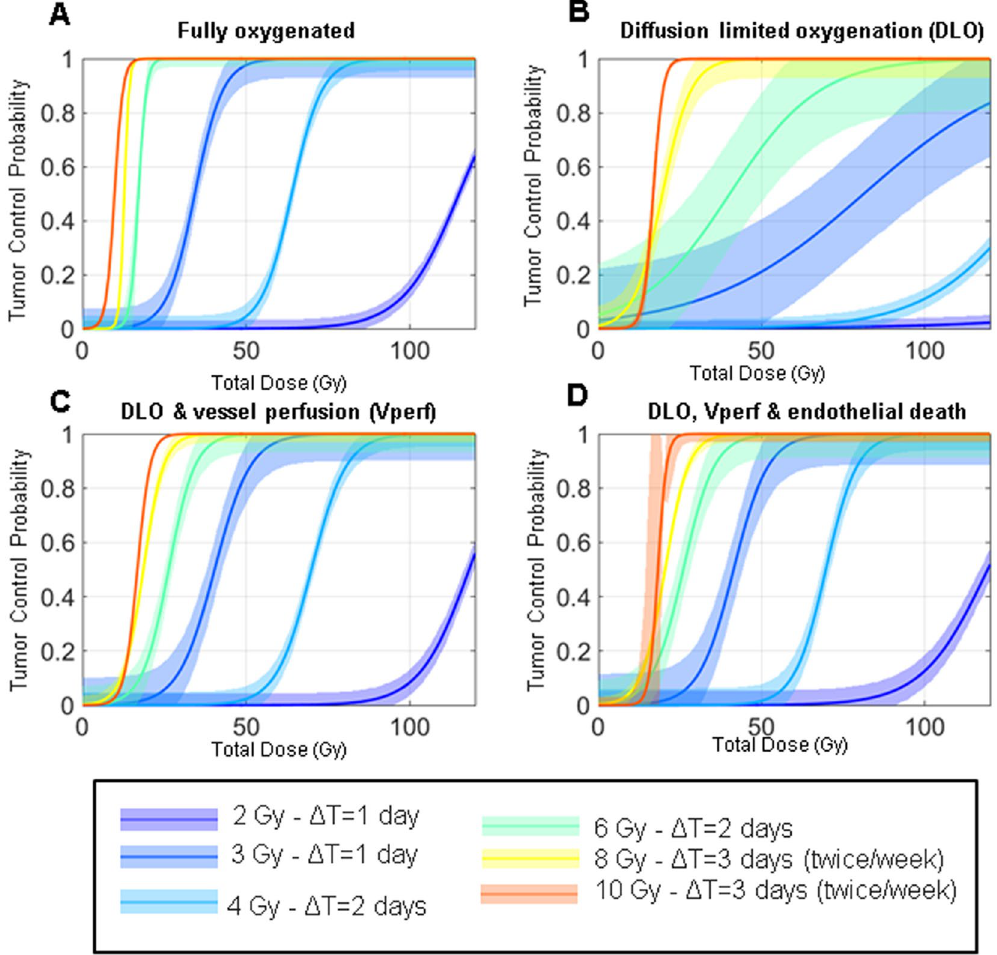
Figure 6. Tumour control probability vs dose/protocol. Sigmoid fits of TCP with 95% confidence interval are shown for various protocols. Simulations using the standard LQ model when tumour is ( A ) fully oxygenated (O2: 21%); ( B ) O2 diffusion is limited (O2: < 5%; Diffusion limited oxygenation (DLO)); ( C ) DLO and irradiation-induced vessel perfusion (Vperf); ( D ) DLO, Vperf and hypoxia driven by irradiation-induced endothelial cell